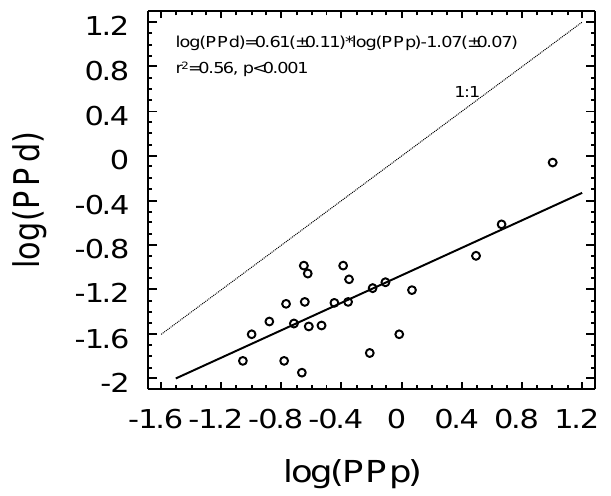
Fig. 3. Linear regression (Model II) of log-transformed particu- late (PPp, mgCm − 3 h − 1 ) and dissolved primary production (PPd, mgCm − 3 h − 1 ) pooling all measurements made during this study.